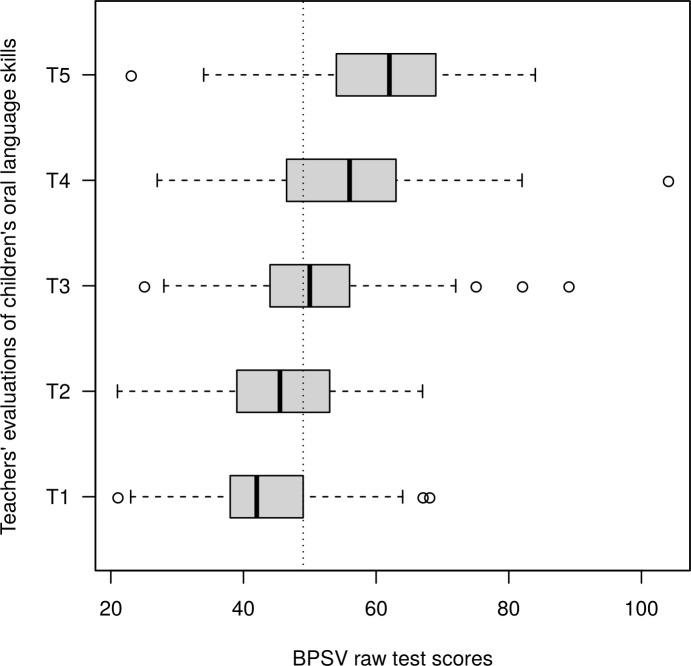
Teachers’ assessments of children’s oral language skills and the BPVS raw scores.The dotted line (the BPVS raw score of 49) indicates the median for the whole group.